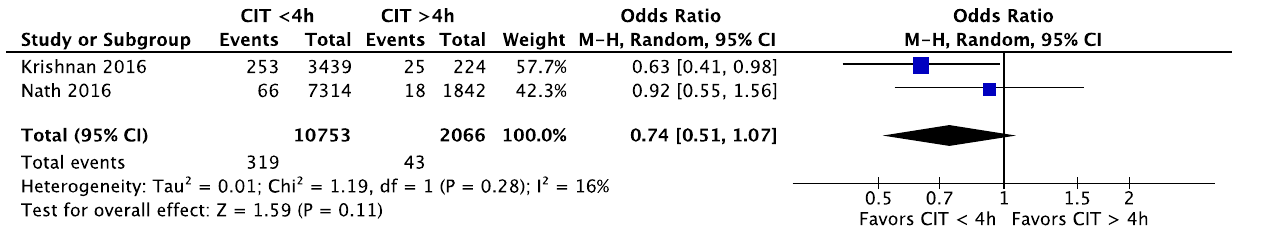
Figure 12. One-year patient survival for CIT shorter and longer than 4 h. CIT: cold ischaemia time.